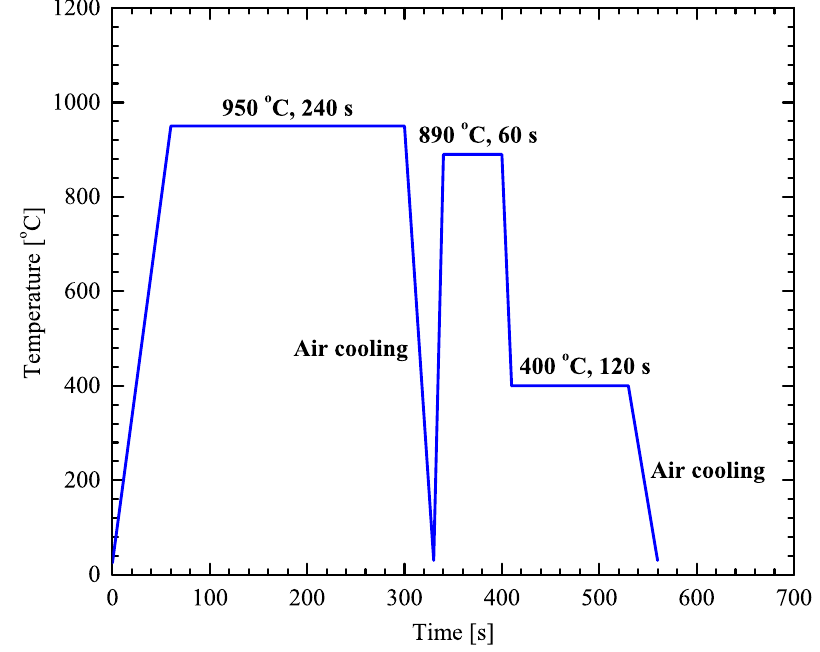
Figure 3. Heat treatment process of studied